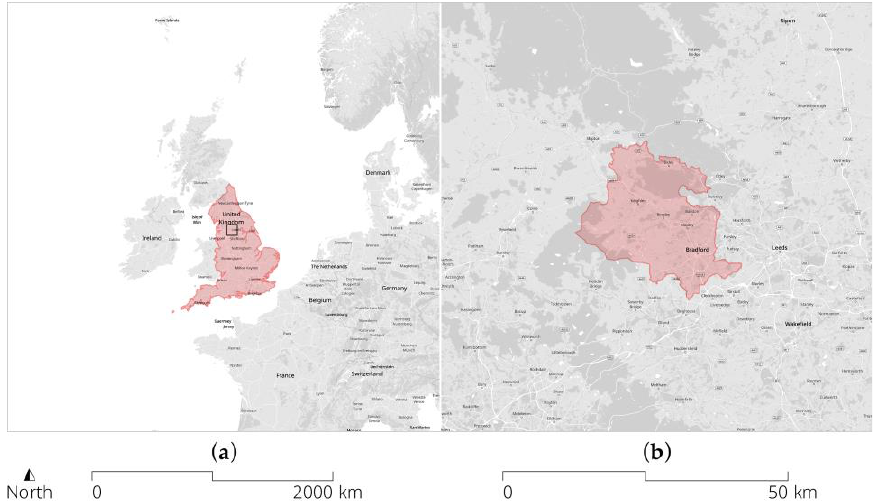
Figure 1. Context map showing England, located in Western Europe ( a ), and the City of Bradford Metropolitan District within the north of England ( b ). © OpenStreetMap contributors and © OS and Crown copyright 2022.